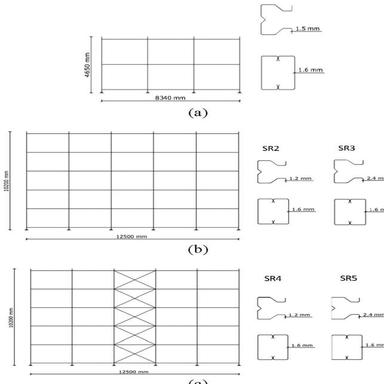
Representative storage rack frames of the current racking inventory in Australia: a) SR1, b) SR2 and SR3, C) SR4 and SR5.